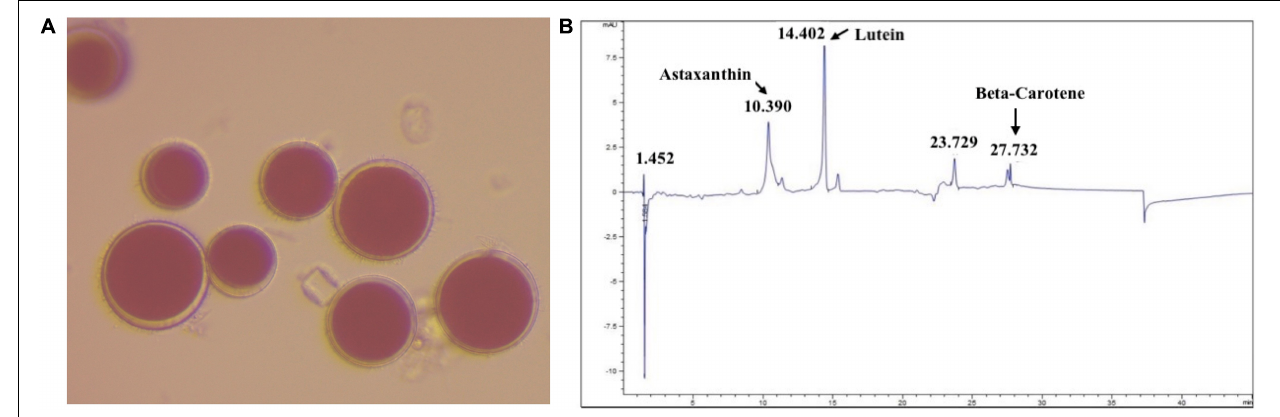
FIGURE 1 | (A) Image of magnified H. pluvialis culture (magnification, 40 × ). (B) HPLC-chromatograph of the pigments extracted from H. pluvialis biomass.